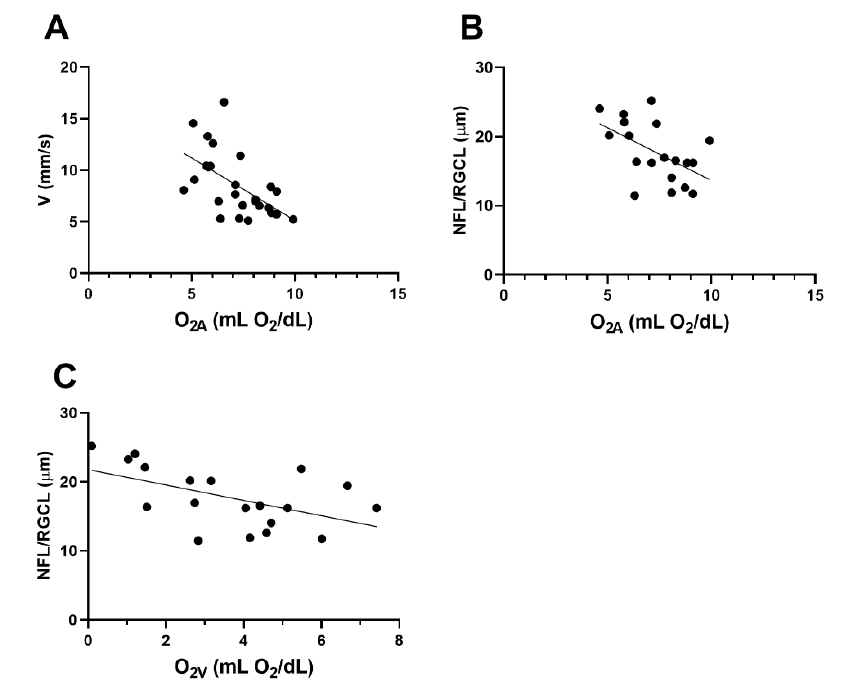
Figure 7. Based on compiled data from wild-type (WT) and five-familial Alzheimer’s disease (5XFAD) mice: ( A ) relationship between venous velocity (V V ) and arterial oxygen content (O 2A ). ( B ) and ( C ) The relationships of nerve fiber layer/retinal ganglion cell (NFL/RGCL) thickness to O 2A and venous oxygen content (O 2V ), respectively.